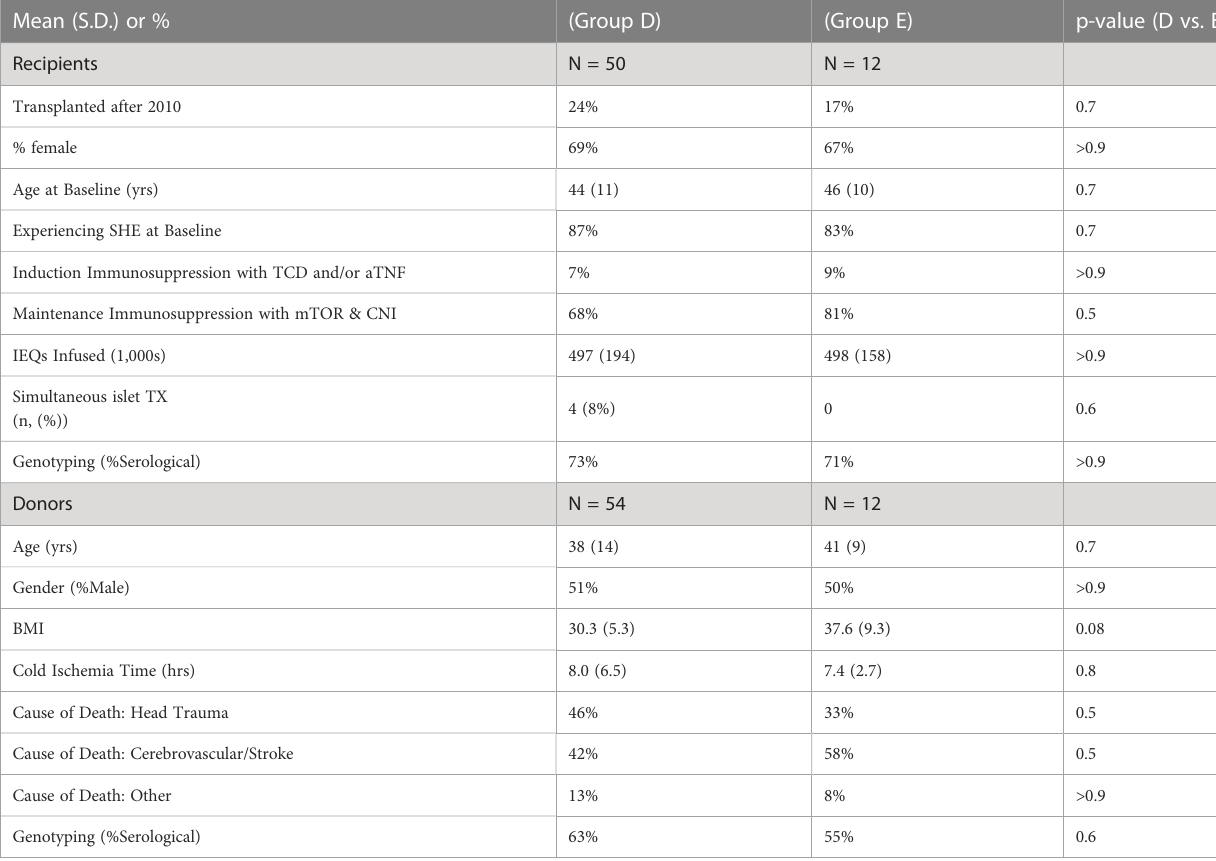
TABLE 5 Key baseline characteristics of islet transplant recipients and